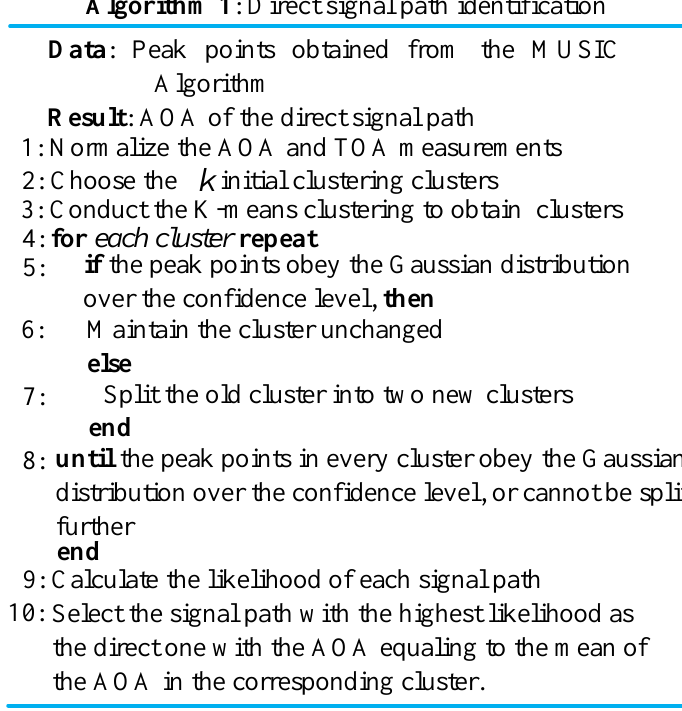
Algorithm 1 : Direct signal path identification